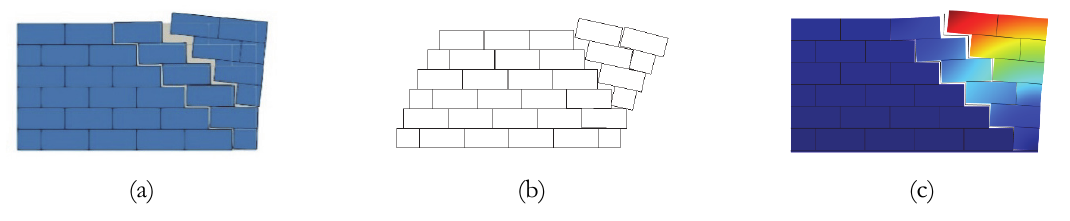
Figure 4: Collapse mechanism for Example 1, horizontal live load: ( a ) ALMA 2.0, ( 𝑏 ) FEM/DEM, ( 𝑐 )